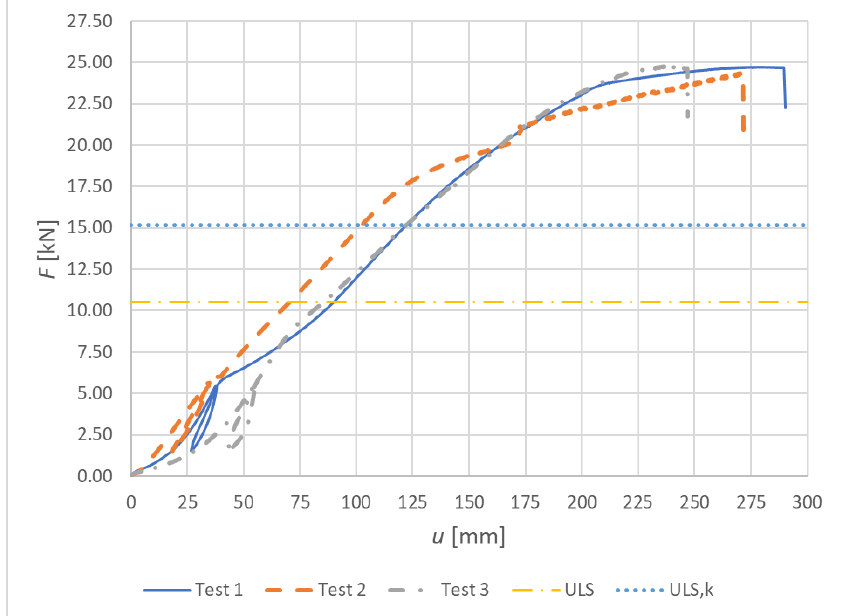
Figure 14. Experiment B, fully threaded screws: ( a ) test 1; ( b ) test 2; ( c ) test 3. Figure 15 shows load – deformation curves from the experimental testing for Experi- ment B, fully threaded screws.